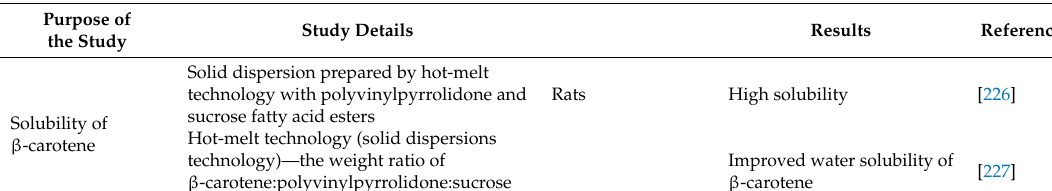
Table 6. The impact of solid dispersion and microemulsions on the solubility and bioavailability of